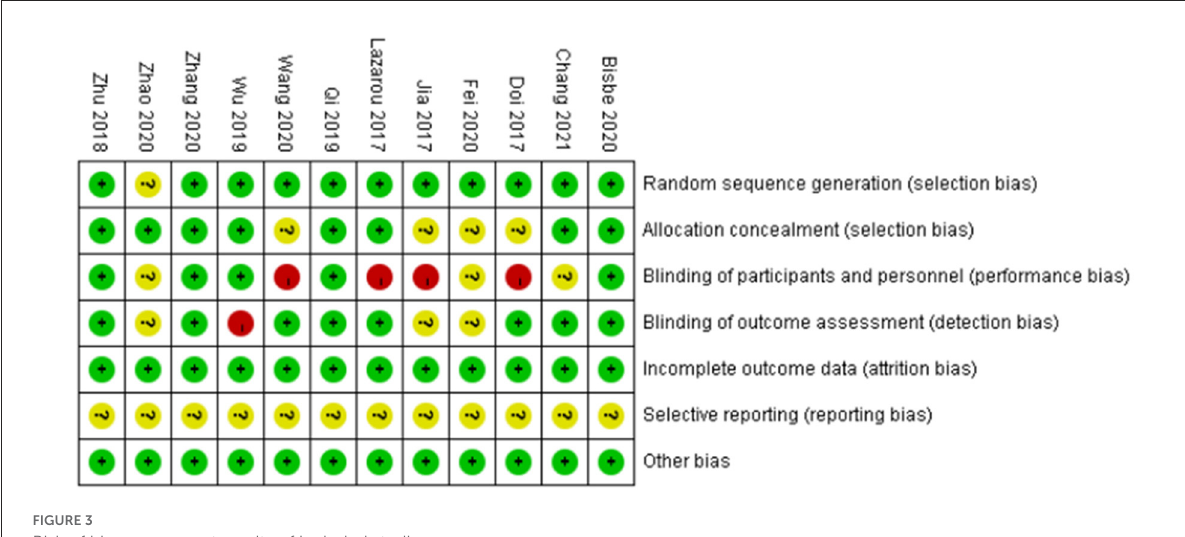
FIGURE3 Risk of bias assessment results of included